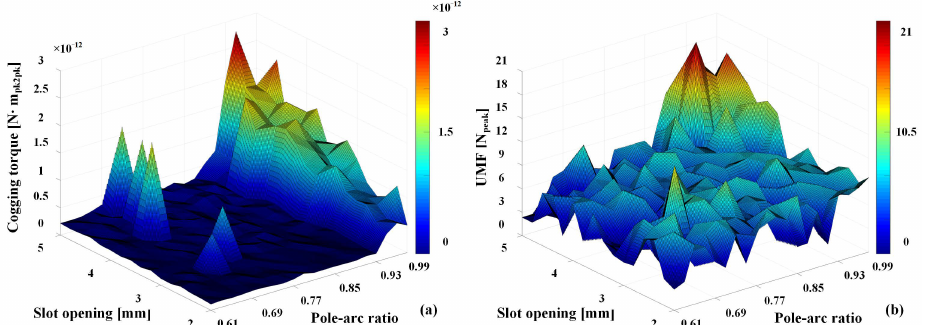
Figure 9. Parametric analysis under the no-load condition: ( a ) cogging torque; ( b ) UMF.